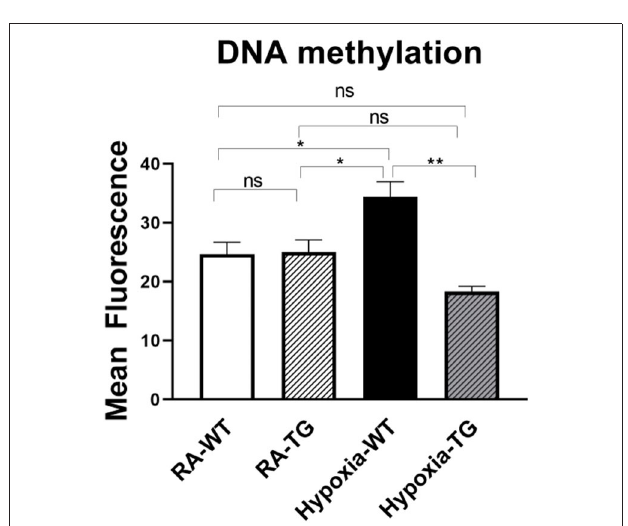
FIGURE 4 | Flow cytometry studies for DNA methylation—In in-vitro studies using cardiac fibroblasts, DNA methylation levels were assessed in cells exposed to hypoxic conditions (FiO 2 1% for 72h) and compared to cells transfected with EC-SOD and exposed to hypoxia. Cells cultured in room air were employed as controls. Triplicate wells were analyzed, and the experiments were repeated five times. Data represents mean ± SEM. * P < 0.05, ** P < 0.01, *** P < 0.001, **** P <